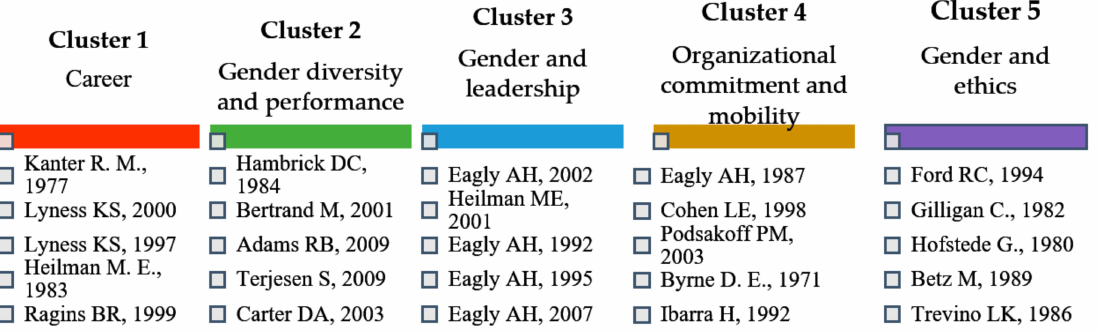
Figure 7. Co-cites grouped by clusters. Source: Prepared by the